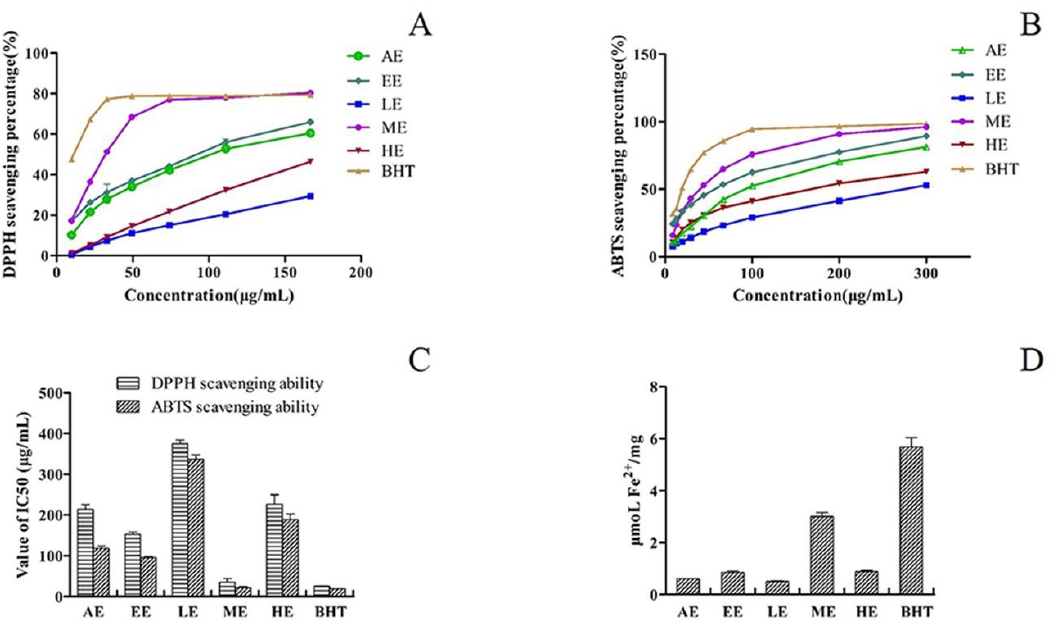
Figure 1. The antioxidant activities and reducing power of different AMF extracts and their fractions. ( A ) DPPH assay; ( B ) ABTS assay; ( C ) IC 50 values for the radical scavenging activities of different AMF fractions; ( D ) FRAP assay.